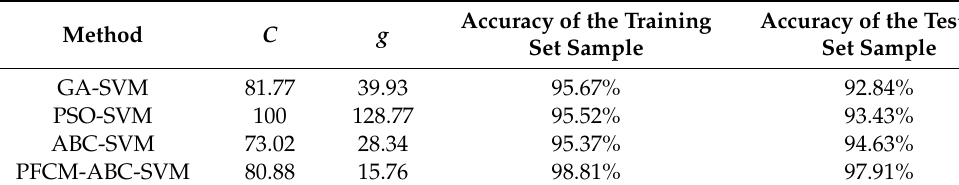
Table 4. The comparison between the PFCM-ABC-SVM method and the other methods.